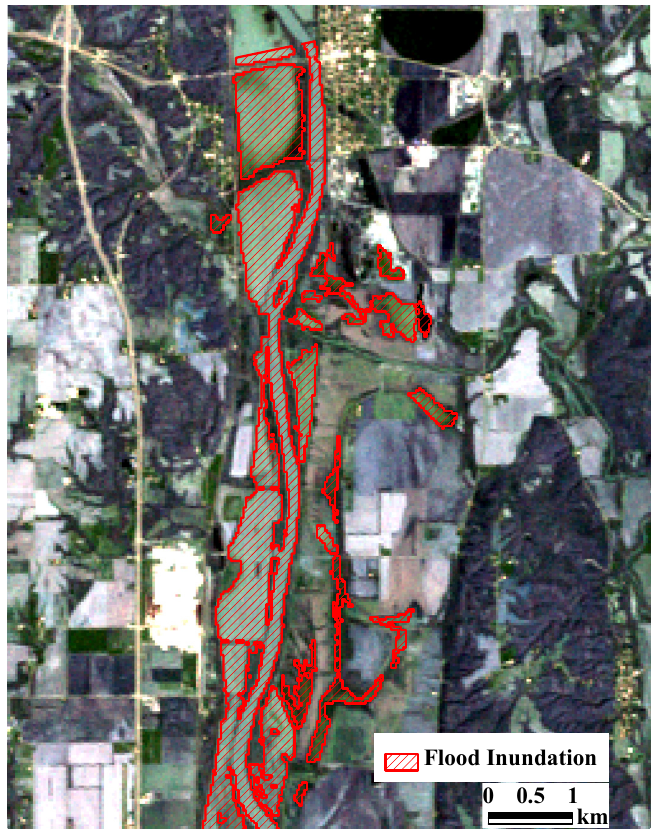
Figure 4. The flood inundation map extracted from Landsat Image (the Montezuma reach, 11 April